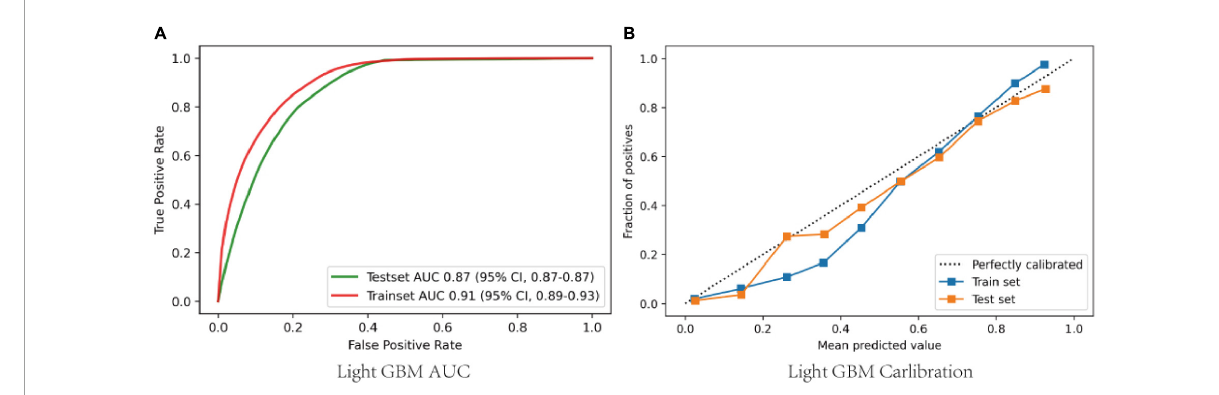
FIGURE4 (A) ROCs of the LGBM after adjusting and optimizing the parameters; (B) Calibration curves of the LGBM after adjusting and optimizing the parameters. ROC, Receiver operator characteristic curves; GBM, gradient boosting machine.